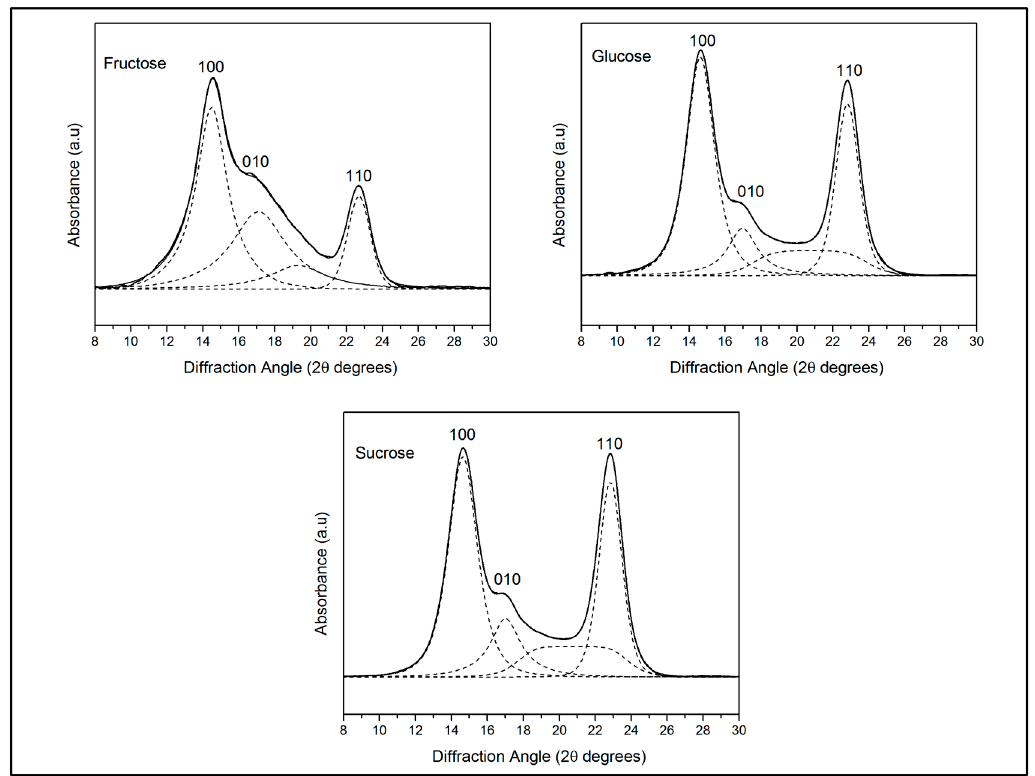
Figure 7 . XDR patterns of bacterial cellulose produced from different substrate: ( a ) glucose; ( b ) fructose; and ( c ) sucrose. Table 4. D-spacing, ACS, and crystallinity index in different media. Table 4. D-spacing, ACS, and crystallinity index in different